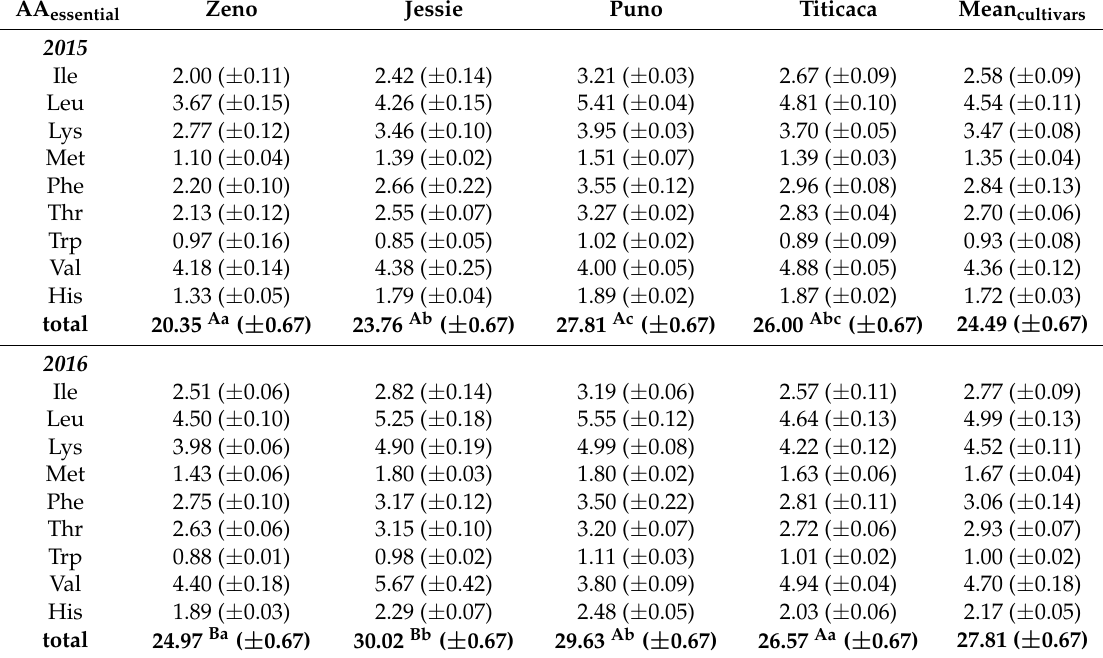
Table 5. Composition of essential amino acids (AA) (in g 100 g − 1 crude protein, ± SE 1 ) for the two years and four quinoa cultivars (Zeno, Jessie, Puno, Titicaca). Total amount means within year in one row followed by the same lower-case letter are not significantly different from each other ( p < 0.05). Capital letters compare the two years for the same cultivar, means in one column followed by the same letter are not significantly different ( p < 0.05).